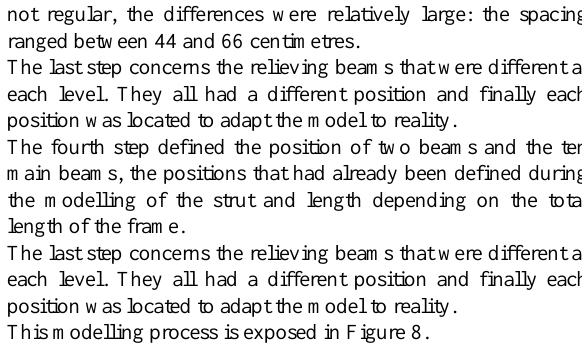
Figures 9c: Details of the 3 rd level of the framework